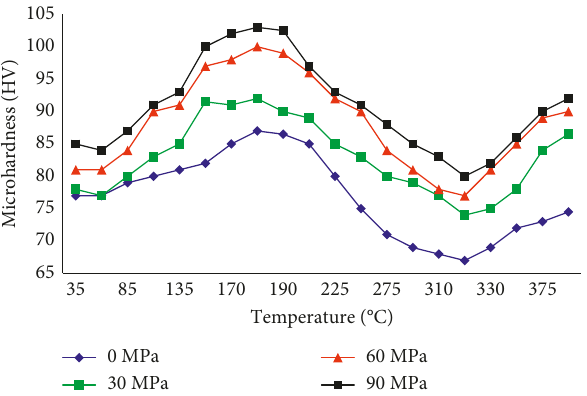
Figure 7: Graphical representation of microhardness values of alloy in heat treatment conditions with various